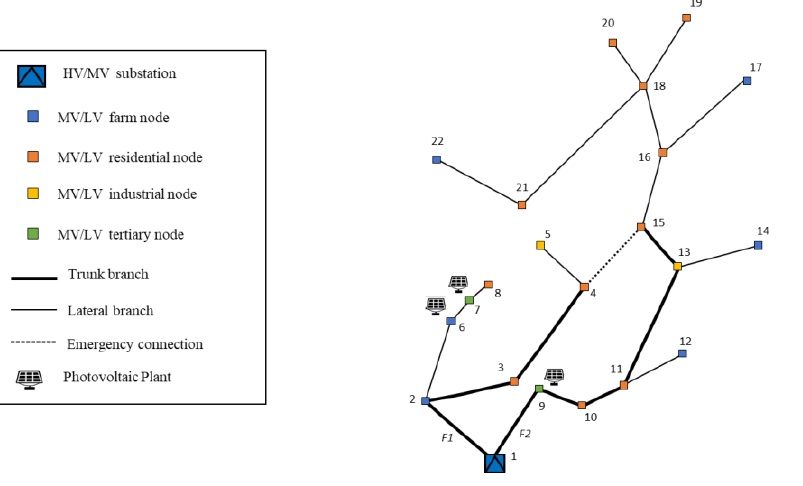
Figure 5 . MV distribution network analyzed . Figure 5. MV distribution network analyzed. Table 1. Load and Generator